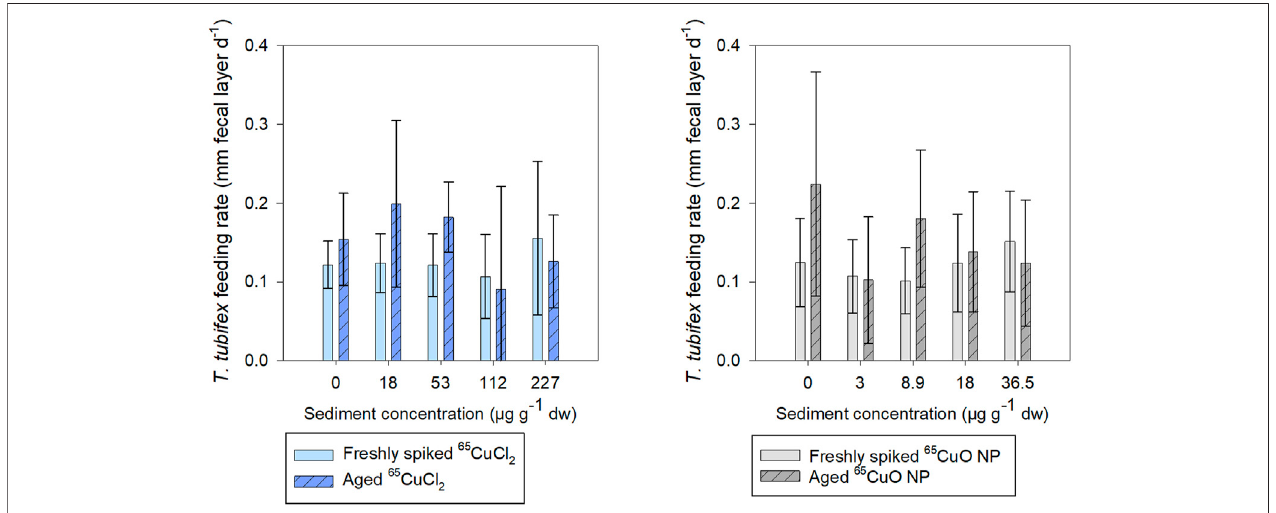
FIGURE5| T.tubifex feedingratemeasuredasincreaseinfecallayerthickness(mmd − 1 )atday27ofexposureinfreshlyspiked(fullbars)oraged(schratchedbars) sedimentwith 65 CuCl 2 [blue, (A) ]or 65 CuONPs[gray, (B) ]at fi vedifferentconcentrations.Fecallayerthicknesswasmeasuredwithcalipersatapre-destinedplaceofthe exposure vial. mean ± SD, n (cid:1) 10.